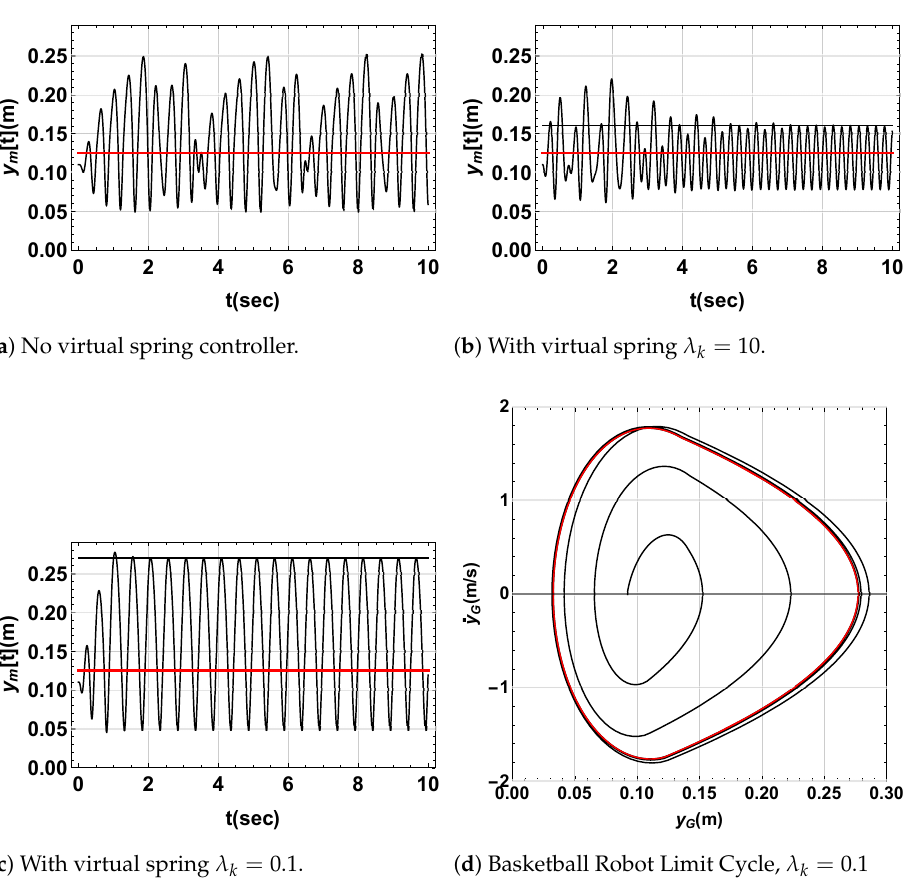
Figure 9. Basketball Jump